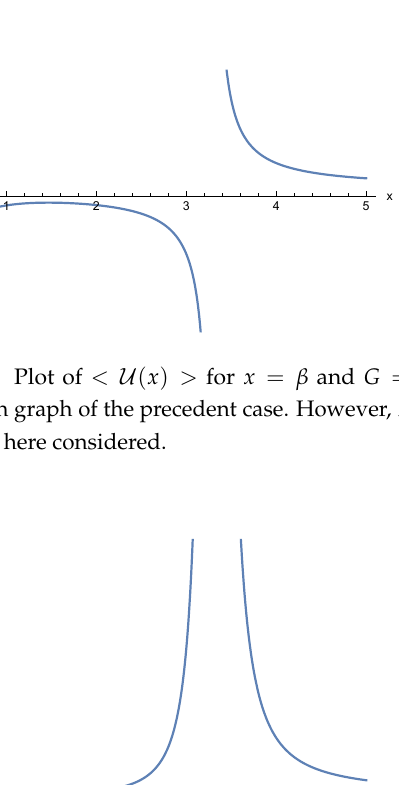
Figure 10. Plot of Z ( x ) for x = β G = m = R 0 = M = 1. Results turn out to be unphysical for x < 3.35, as in the previous case.